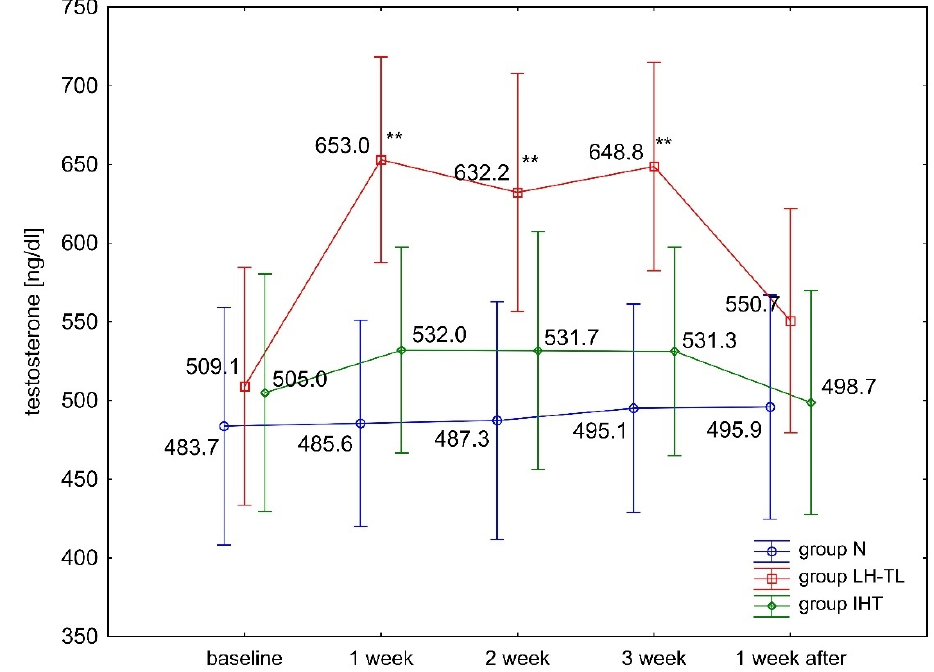
Figure 1. Blood serum testosterone levels (T) in experimental (LH–TL and IHT) and control (N) groups during the first experiment; ** p < 0.01—statistically significant differences compared to baseline.